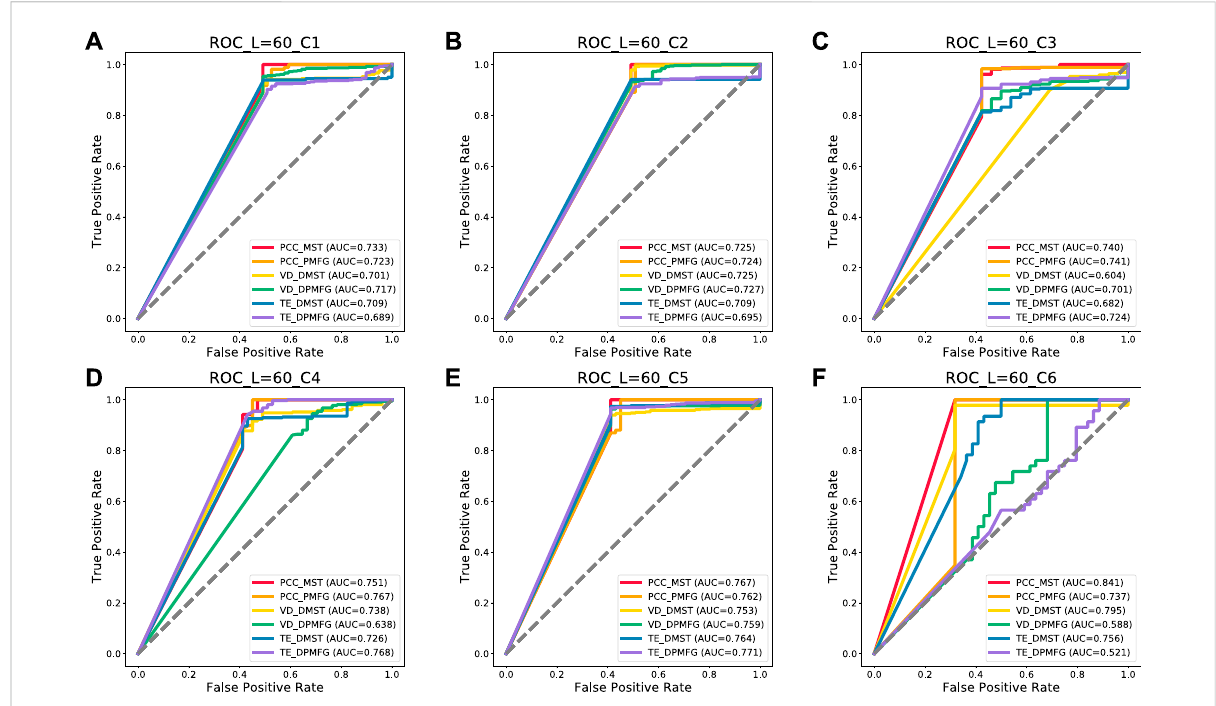
FIGURE 15 Prediction of the six crises of each layer network at 60-day windows. (A – F) indicate the prediction result of each fi nancial crisis. C1 to C6indicatethefollowingcrises:SubprimeMortgage,EuropeanSovereignDebt,RussianRecession,StockMarketSelloff,andTradeCon fl ictbetween China and the United States, US stock circuit breaker,